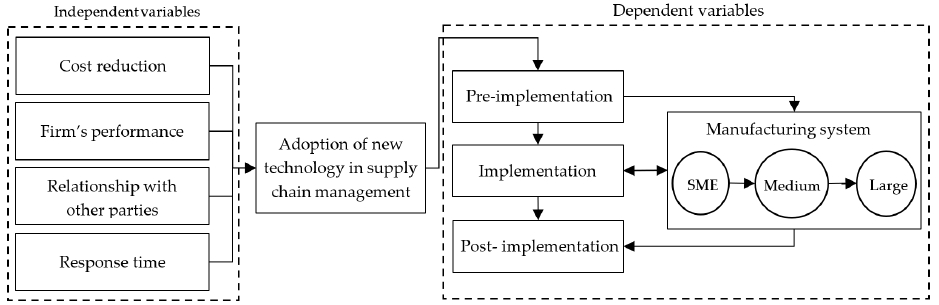
Figure 2. Adoption of new technology conceptual framework.